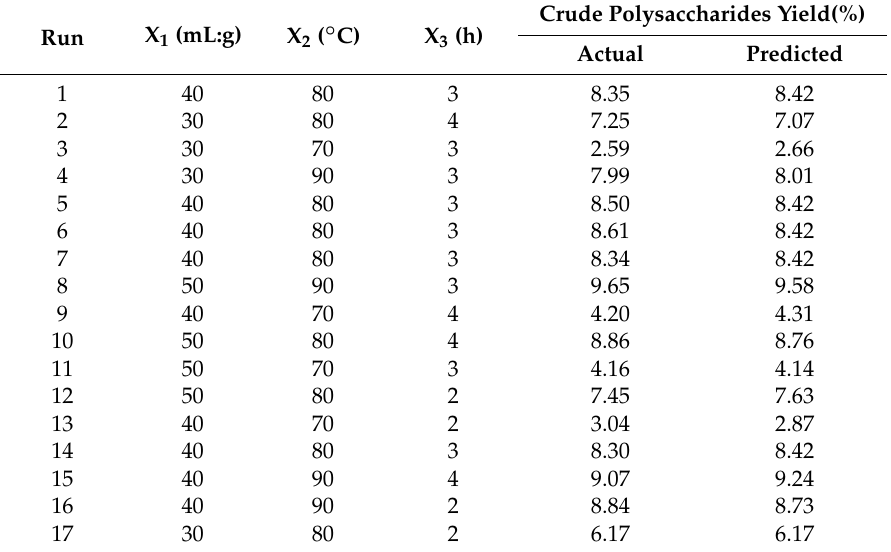
Table 2. Box-Behnken Design (BBD) and the response values for extraction yields of crude polysaccharide. Crude Polysaccharides Yield(%) Run X 1 (mL:g) X 2 ( ◦ C) X 3 (h) Actual